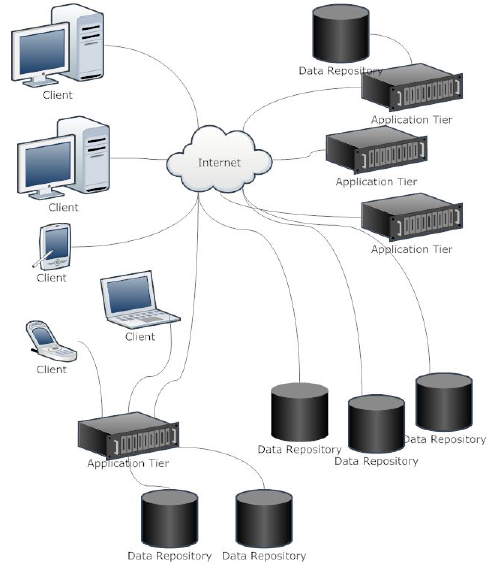
Fig. 1. External and Distributed Database